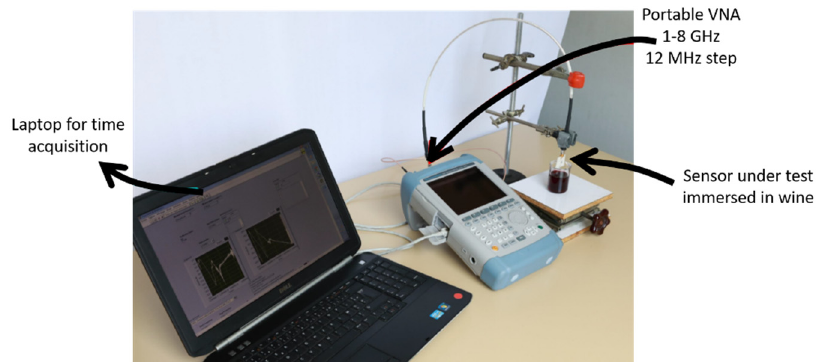
Figure 7. Experimental setup of the microwave measurement test bench.